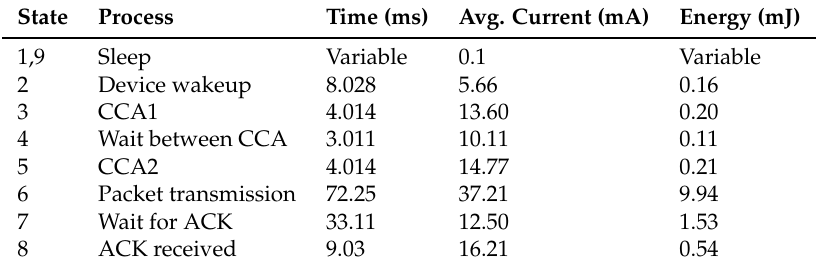
Figure 12. Scope view of a DASH7 PUSH mode captured using power analyzer for the measurement of energy consumption. Table 2. Current composition split into different states of operation for DASH7 PUSH